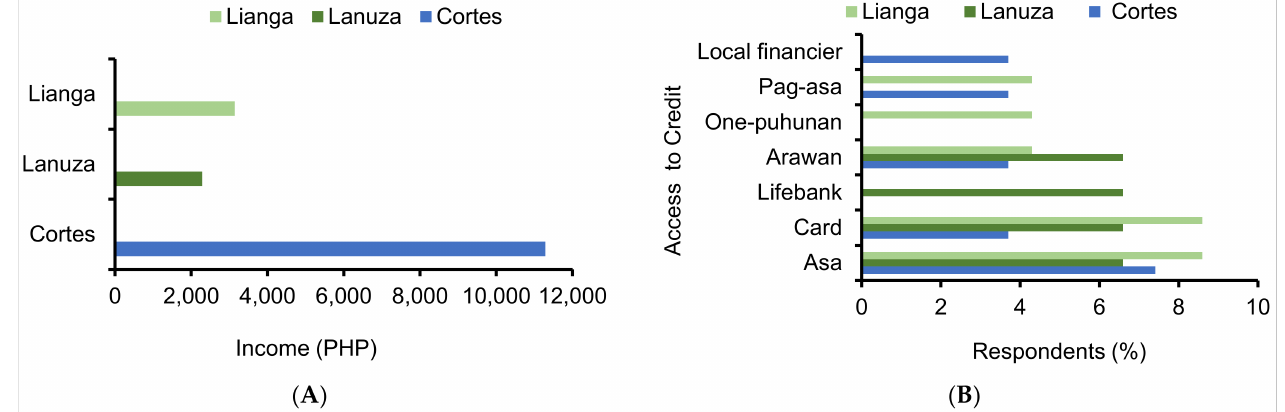
Figure 2. Monthly income of fishers in Lianga, Lanuza and Cortes ( A ) and access to credit of small-scale fishers ( B ) in the three municipalities of Surigao del